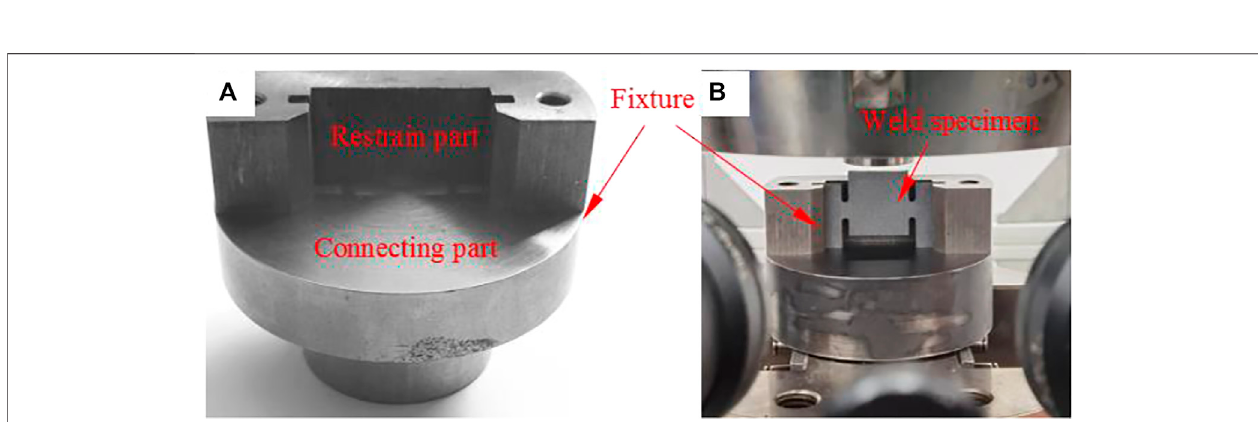
Frontiers in Energy Research |